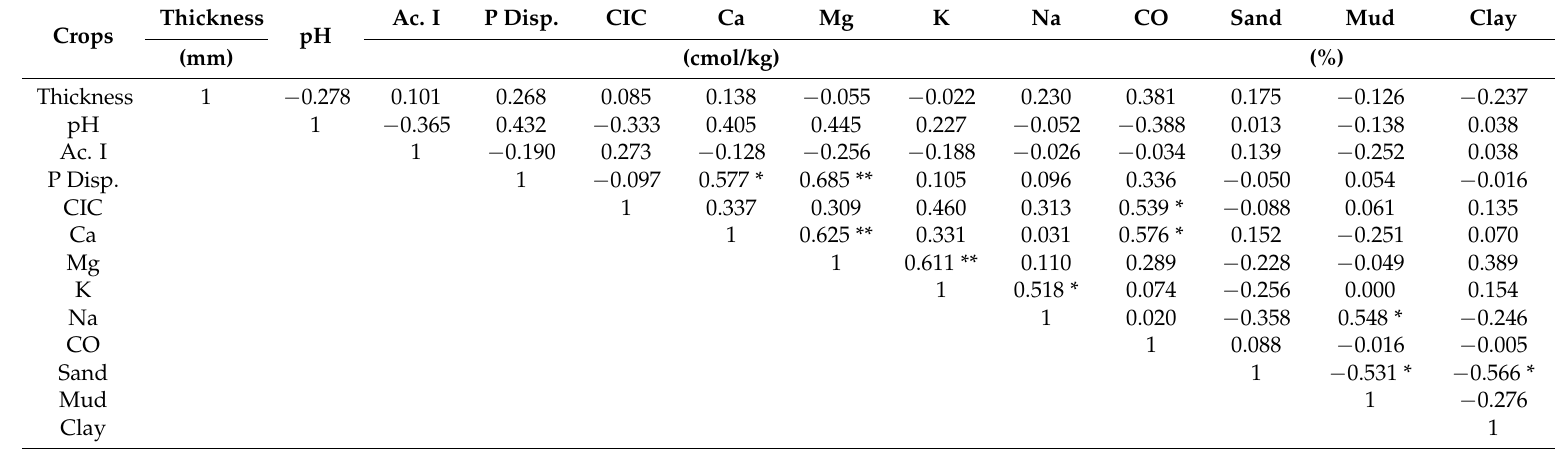
Table 4. Pearson correlation for the physicochemical properties of soils with different uses and coverages. * The correlation is significant at the 0.05 level (bilateral); ** The correlation is significant at the 0.01 level